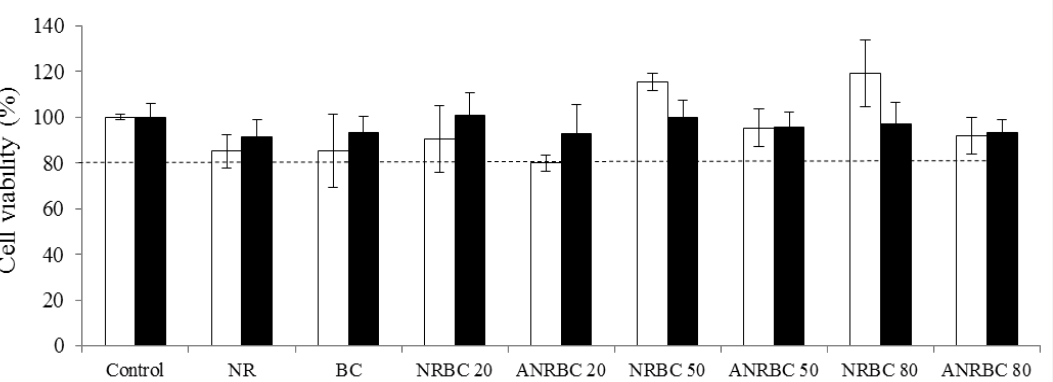
■ ) cultured in extract medium of the NR,